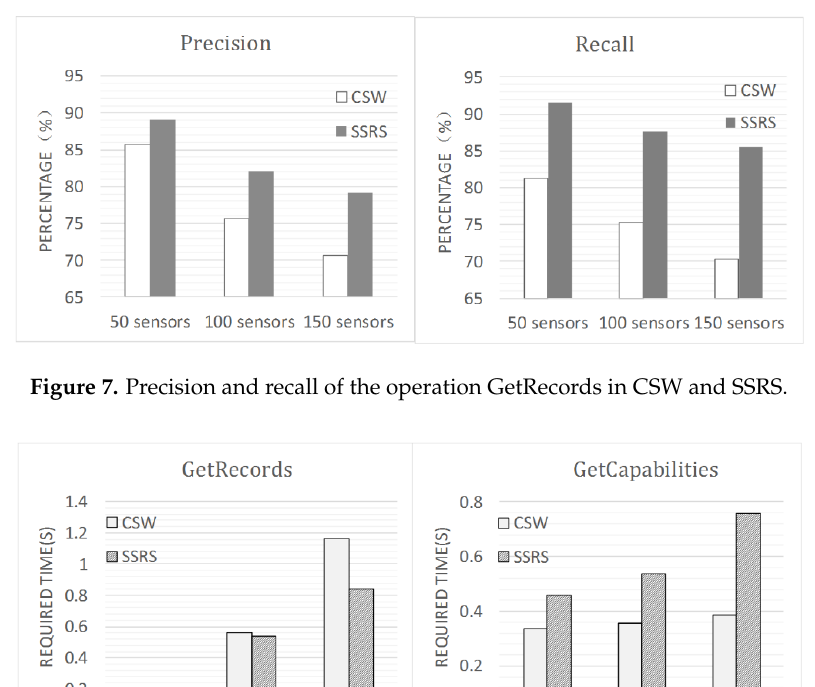
Figure 7. Precision and recall of the operation GetRecords in CSW and SSRS.